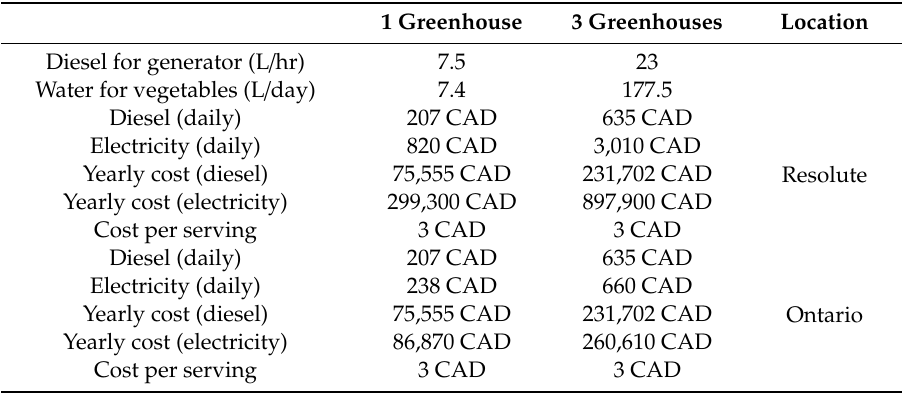
Table 13. Operational costs for 96 (cid:48) × 30 (cid:48)